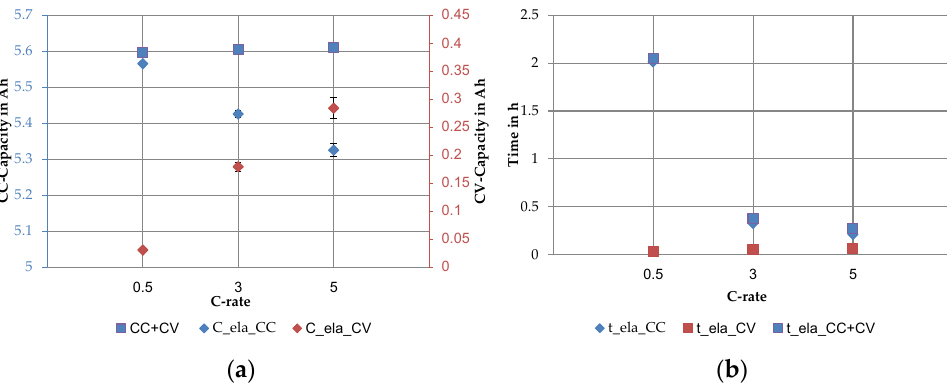
Figure 8. The main results of the current rate dependent performance test section averaged over all cells: ( a ) share of the CC vs. CV discharge capacity and average capacity, cycle C9–C11 and ( b ) share of the time for the CC vs. CV discharge step, cycle C9–C11.